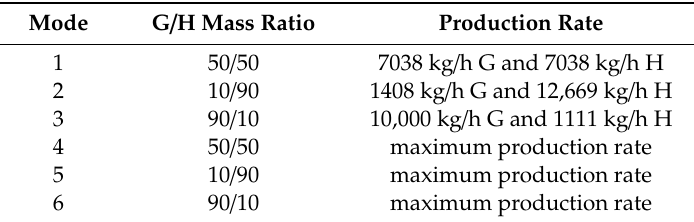
Table 1. Six operation